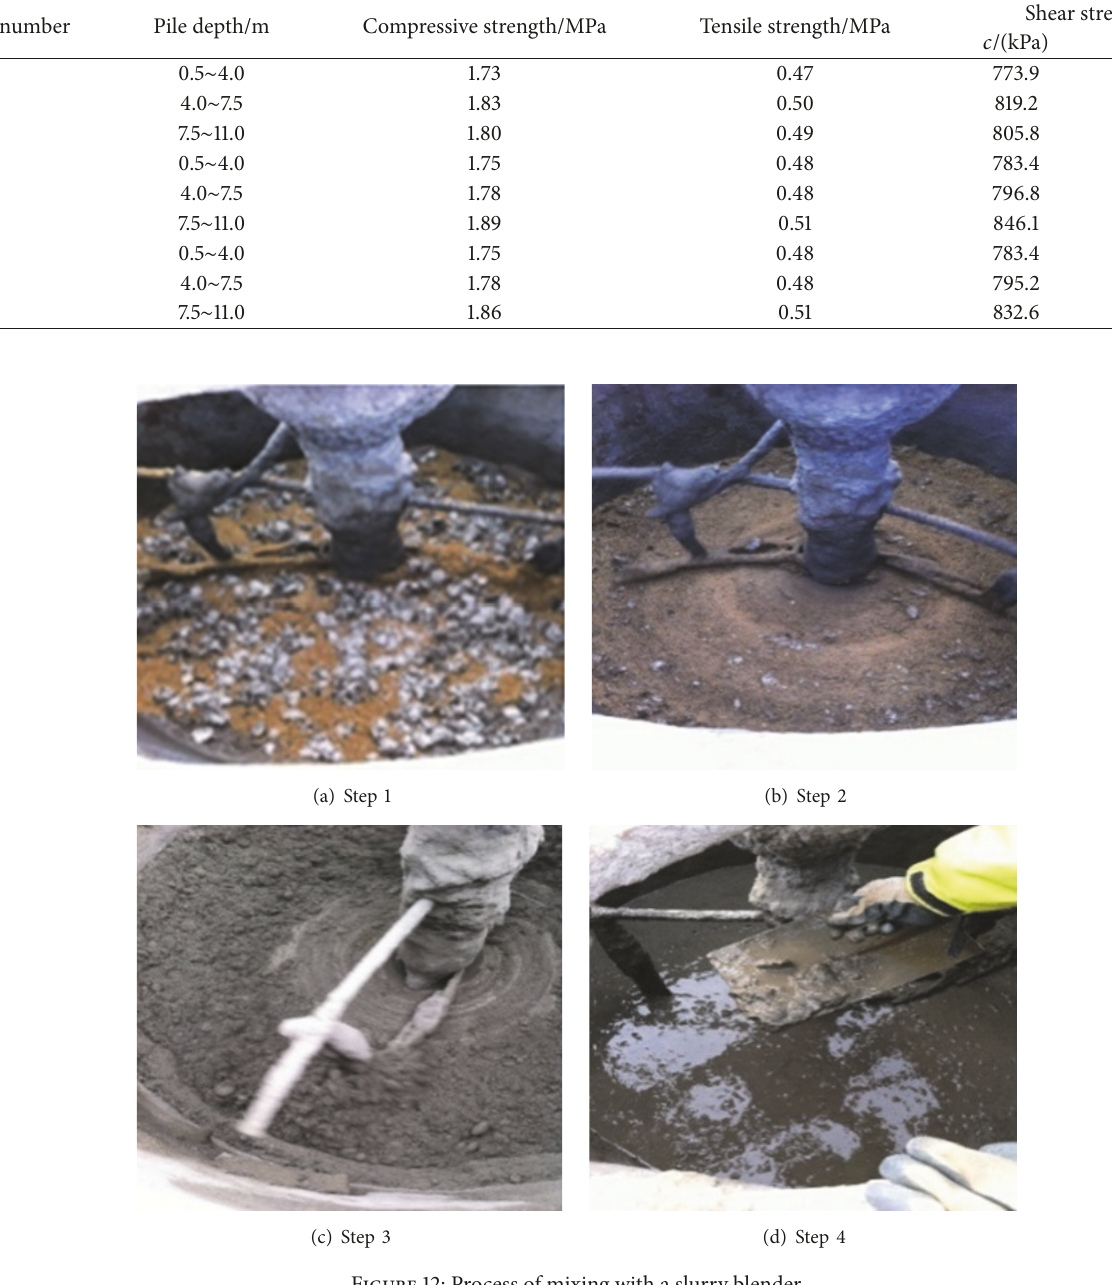
Figure 12: Process of mixing with a slurry